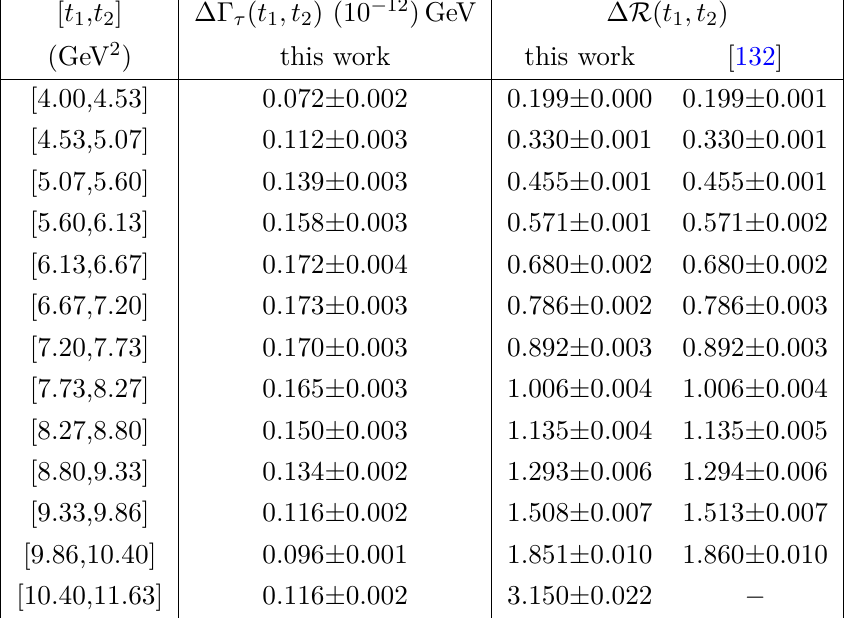
Table 7 . Theory predictions for the partial decay rates of B → Dτν τ and for the binned distributions of ∆ R ( t ) . Our predictions are comparable to [132] albeit with slightly larger error bars in general 1 , t 2 due to large uncertainties from